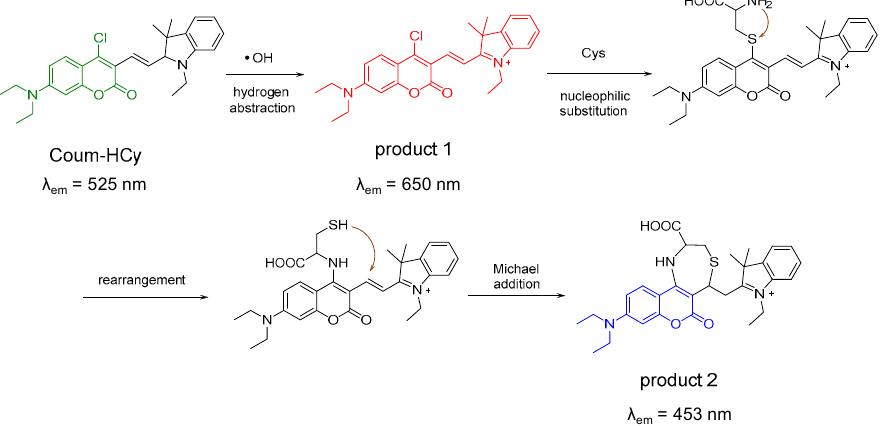
Figure 9. The sequential response mechanism of Coum − HCy to • OH and Cys. Reprinted/adapted with permission from Ref. [52]. Copyright 2022, Elsevier.